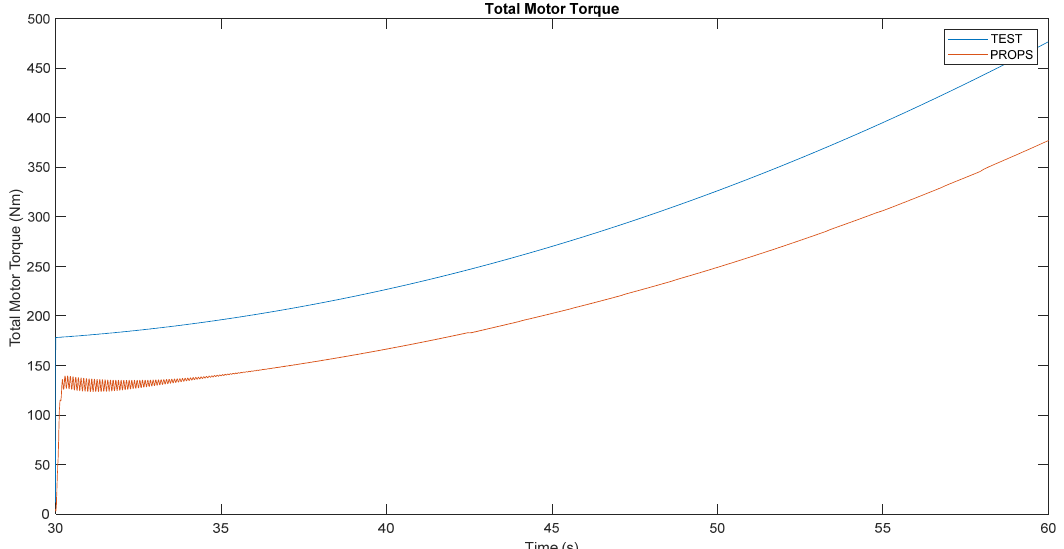
Figure 18. Comparison between TEST (without calibration) and PROPS total torques during the execution of the calibration speed profile.